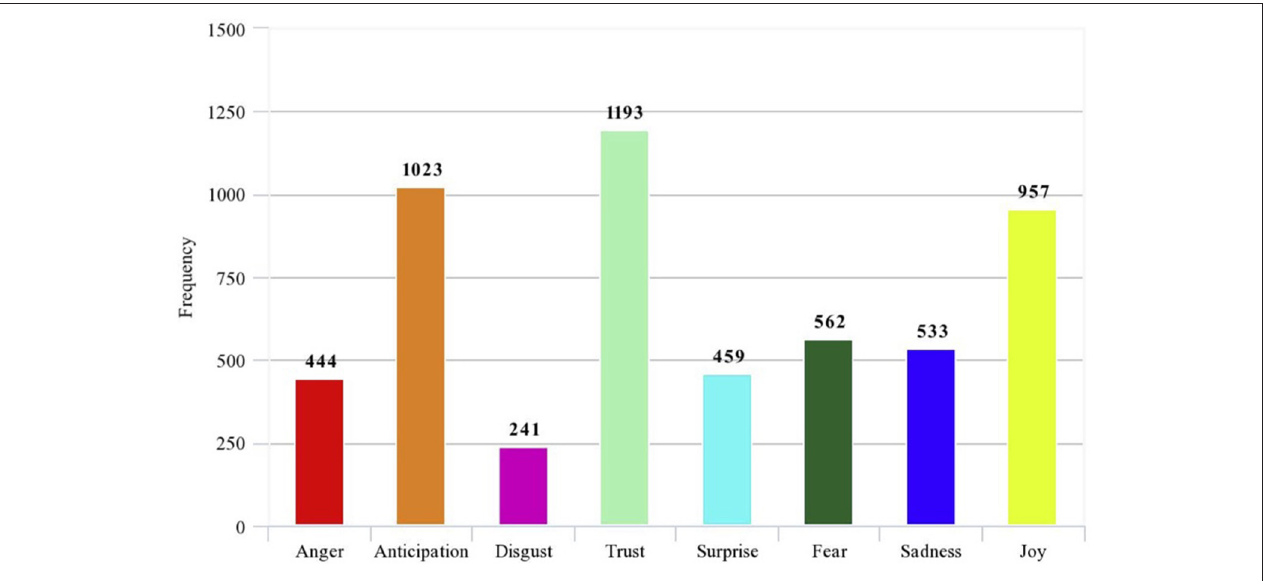
FIGURE 1 | Results of machine-learning-based sentiment decomposition analysis.